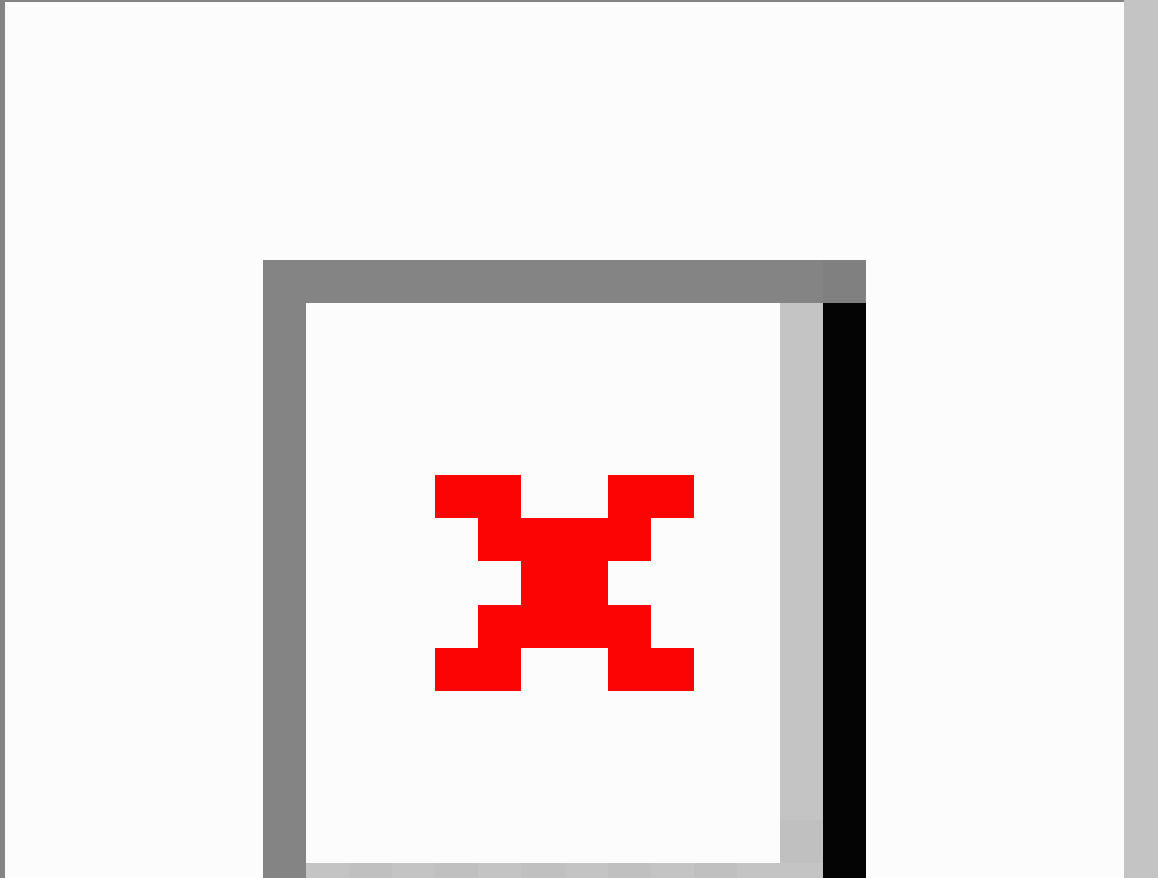
Figure 4. Illustration of the inclusion of the state “Reasoning” (inside the hatched rectangle) that determines when an alarm trigger(s) causes a